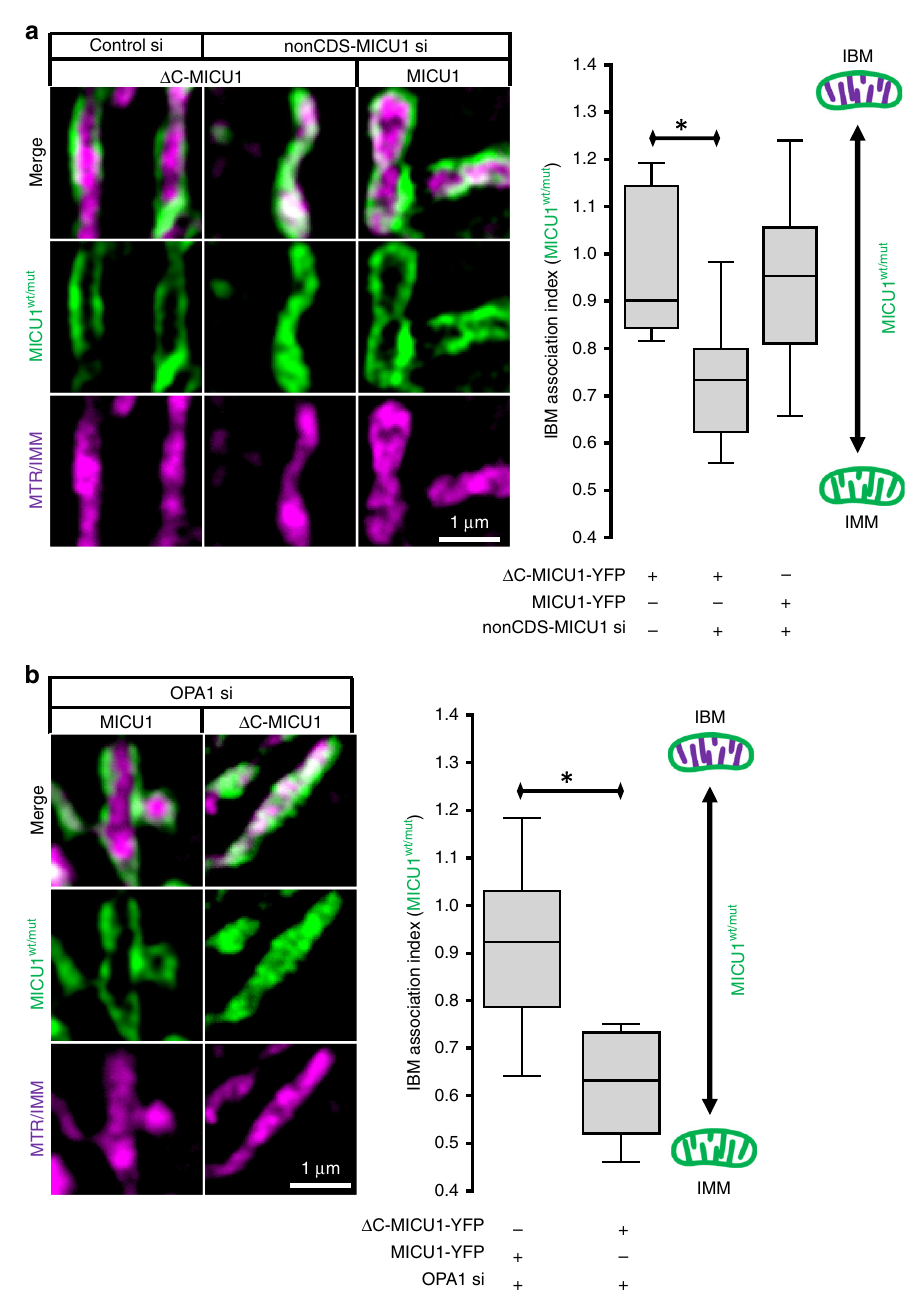
Fig. 3 The C-terminal domain of MICU1 maintains IBM localization. a Left panel shows representative SIM images of HeLa cells stained with MTR (magenta) and expressing Δ C-MICU1-YFP (green) or MICU1-YFP (green) and transfected with either non-coding siRNA against MICU1 (nonCDS- MICU1 si) or control siRNA (Control si). In the right panel the respective statistical analyses of the distribution of MICU1 or Δ C-MICU1 after knockdown of constitutive MICU1 (nonCDS-MICU1 si) or OPA1 (OPA1 si) are shown. The sub-mitochondrial distribution of MICU1- and Δ C-MICU1-YFP in the IBM and the CM was determined in these experiments with the IBM association index ( n Δ C-MICU1,control si = 8; n Δ C-MICU1,nonCDS MICU1 si = 10; n MICU1, nonCDS MICU1 si = 16) . b Left panel shows representative SIM images of HeLa cells stained with MTR (magenta) and expressing MICU1-YFP (green) or Δ C-MICU1-YFP (green) and transfected with siRNA against OPA1 (OPA1 si). The IBM association index was determined for the distribution of MICU1-YFP and Δ C-MICU1- YFP with OPA1 knockdown in the right panel ( n MICU1, OPA1si = 16; n Δ C-MICU1, OPA1si = 8). Horizontal lines represent the median, the lower and upper hinge show respectively fi rst quartile and third quartile, and lower and upper whisker encompass minimal and maximal values. * P < 0.05 vs. respective control conditions carried out with analysis of variance (ANOVA) with Bonferroni post hoc test or unpaired double-sided T -test. Source data are provided as